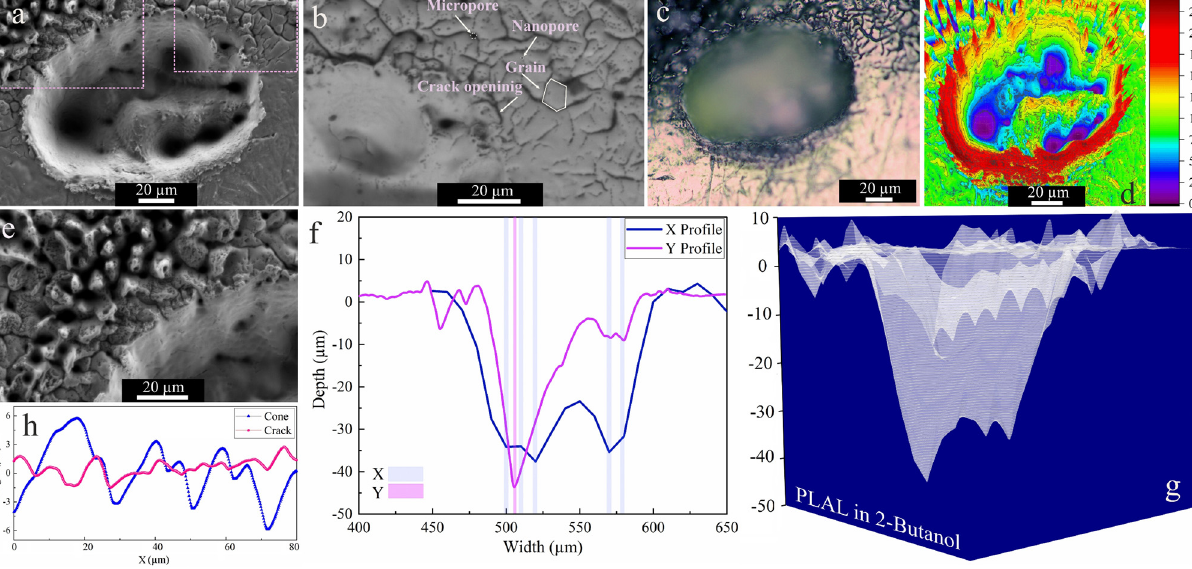
Figure 4. Morphology of a crater formed by PLAL of Au ‐ coated Ni in 2 ‐ butanol ( N = 1000, 1 kHz, E = 250 μ J). ( a , b , e ): SEM images and magnified views of surface morphologies and crater edges; ( c ): optical microscopy of the crater (the green arrow indicates the scan of roughness); ( d ): 3D reconstructed image of an SEM image; ( f , g ): depth profile analyses of femtosecond laser ‐ drilled holes and 3D mapping plot; and ( h ): a surface profile curve of the cone and crack areas. (cid:1)